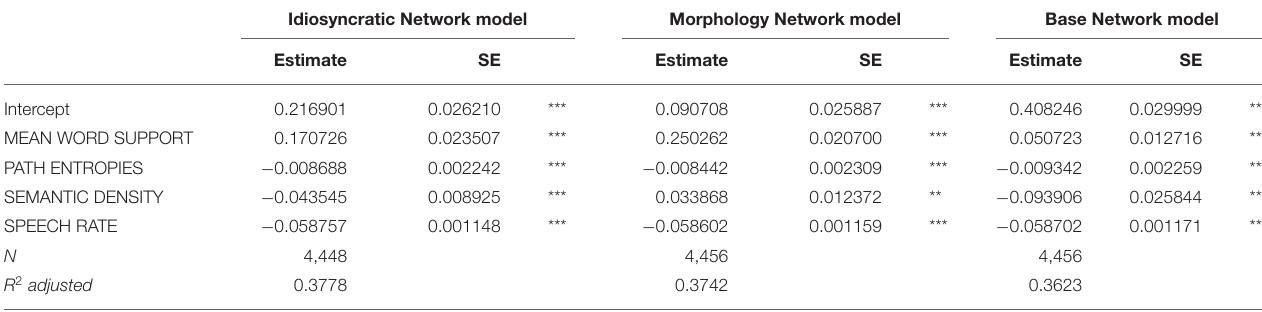
TABLE 3 | Final standard linear regression models reporting effects on duration difference with variables from the three networks.